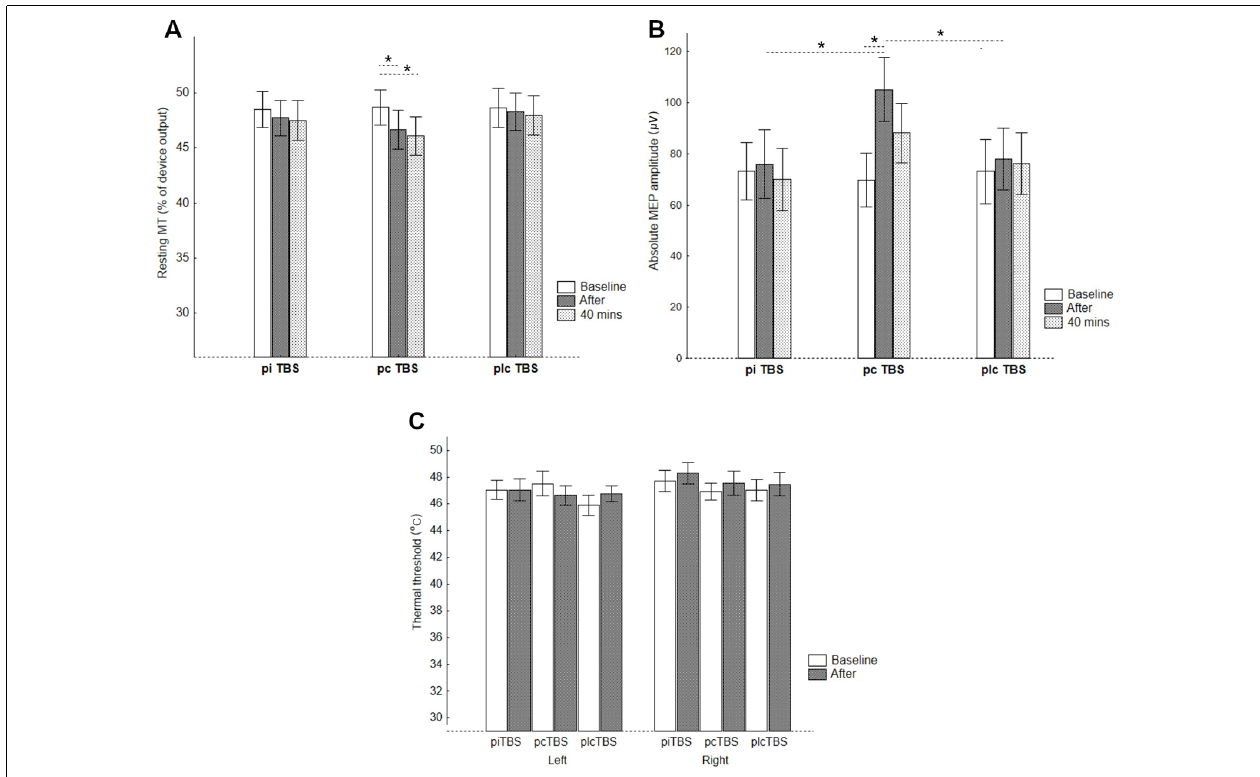
FIGURE 2 | CE represented by (A) RMTs, (B) absolute MEP amplitudes, and pain perception represented by (C) thermal thresholds for the thenar of the left and right thenar eminences after prolonged TBS (pTBS). pcTBS: continuous pTBS; piTBS: intermittent pTBS; plcTBS: placebo TBS. The data are presented as mean ± SE. * p < 0.05 after Bonferroni’s